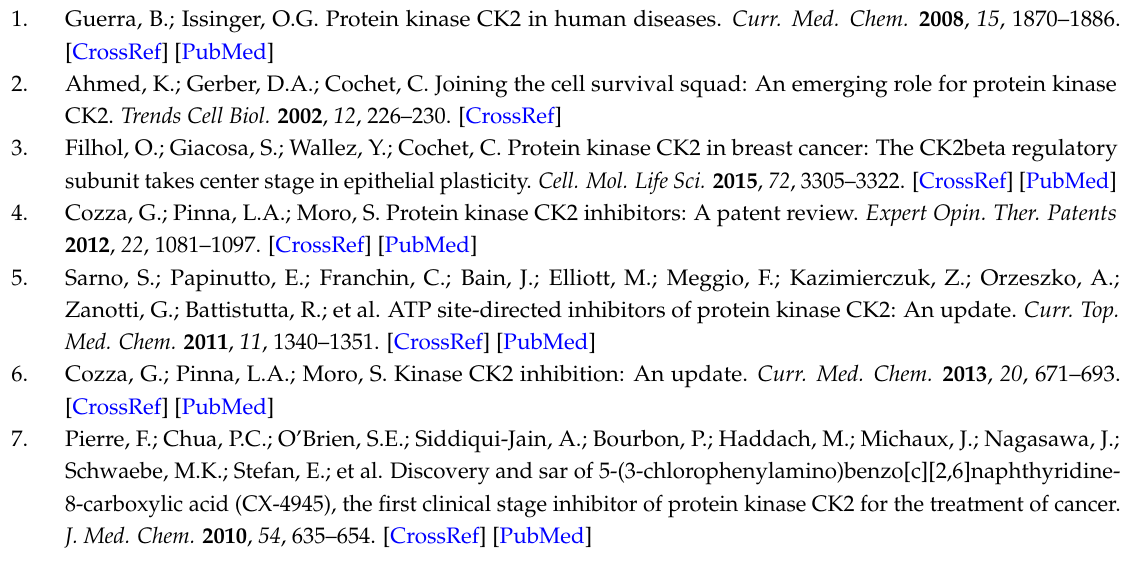
Figure S1: Cellular effects of TAT-Pc 13, Figure S2: Inhibition of TAT-Pc-induced cell